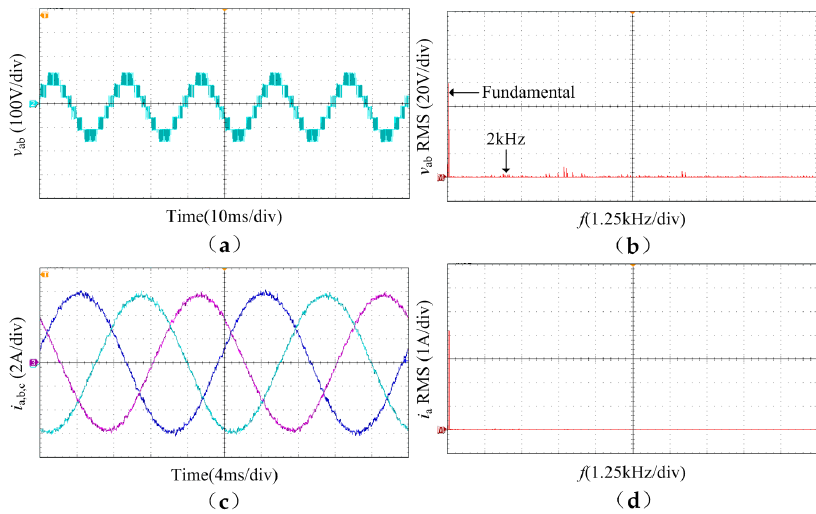
Figure 11. Experimental results under m = 0.6: ( a ) line to line voltage; ( b ) Fast Fourier Transform (FFT) of the line to line voltage; ( c ) three phase currents; ( d ) FFT of the phase current.